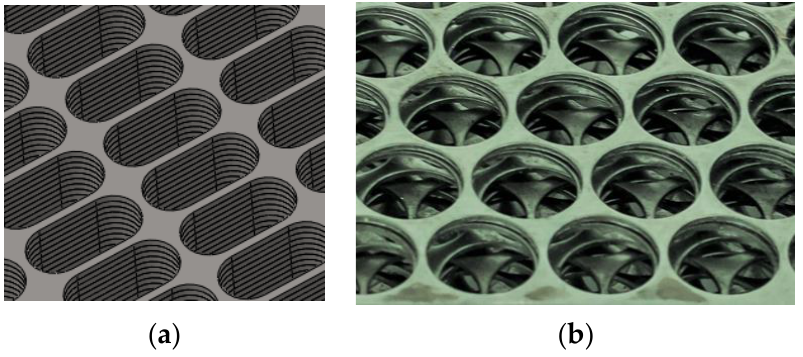
Figure 16. Formation of flow channels in permeable structures: by the layer-by-layer laying of the tape without mutual displacement of layers ( a ); with mutual displacement of cell structure laminar airflow ( b ).